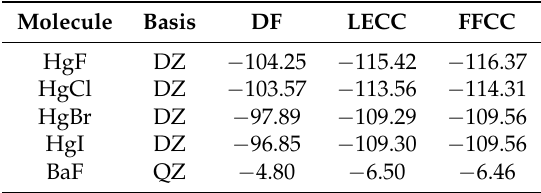
Table 2. Summary of our calculated LECC and finite field coupled cluster method (FFCC) values of E eff for HgX and BaF. We used double zeta (DZ) basis sets for HgX, while BaF’s result is using a QZ basis, with diffuse functions added to Ba. All the units are in